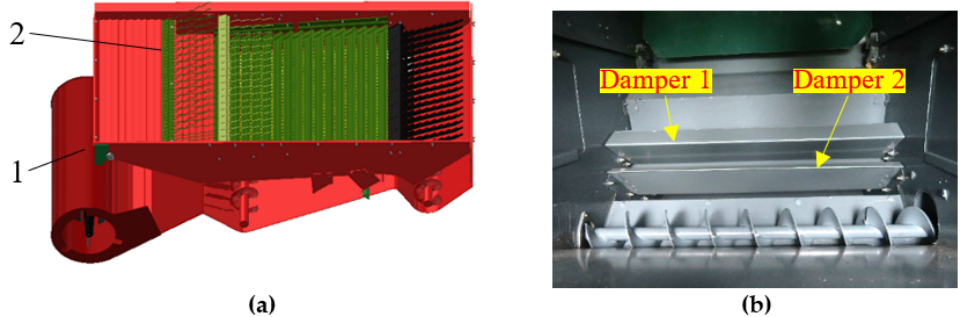
Figure 5. Three-dimensional and internal structure diagram of the air–sieve-type cleaning device: (1) centrifugal fan; (2) layered impurity-controlled sieve. ( a ) Three-dimensional diagram of the air–sieve-type cleaning device. ( b ) Internal structure diagram of the air–sieve-type cleaning device.